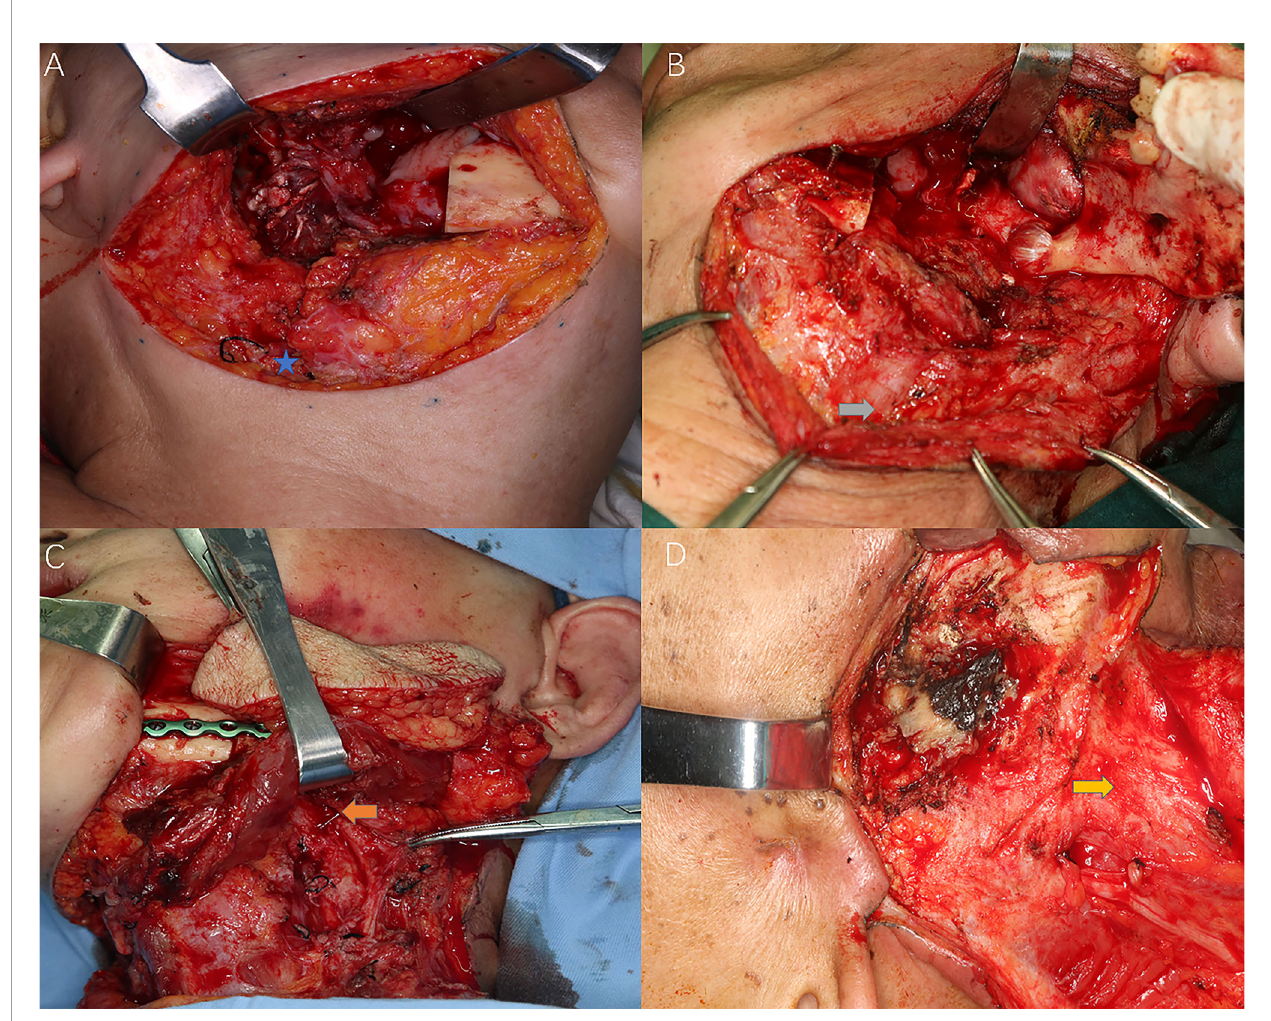
FIGURE 2 | Different levels of cervical fi brosis found intraoperatively for the re fl ection of radiation-induced STIs. Blue star: external jugular vein (EJV); Grey arrow: sternocleidomastoid (SCM) muscle fi brosis and EJV stenosis; Orange arrow: stenosis of facial artery; Yellow arrow: frozen neck with inseparable fi brotic cervical sheath. (A) Slight subcutaneous fi brosis without external jugular vein stenosis; (B) Intermediate muscular fi brosis [sternocleidomastoid muscle (SCM)] with external jugular vein stenosis; (C) Severe fi brosis with both SCM and super fi cial artery (facial artery) stenosis; (D) Frozen neck with inseparable fi brotic internal jugular vein or cervical